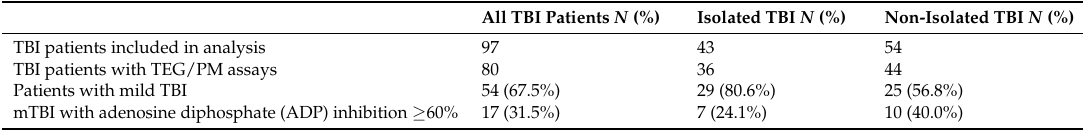
Table 1. Platelet Inhibition in mild traumatic brain injury (TBI) patients with computed tomography (CT) abnormalities.